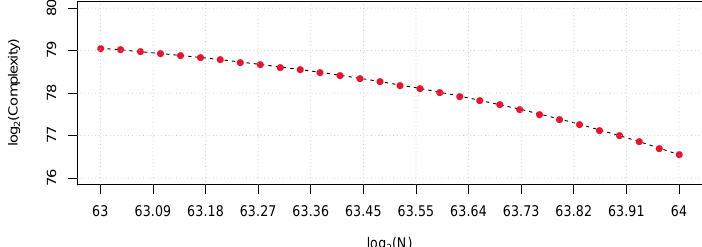
Figure 6: Our 27 round attack: Computational complexity as a function of data complexity for the 27-round attack on present using 135 approximations over 23 rounds. Distinct random texts were used, and P S = 0 .